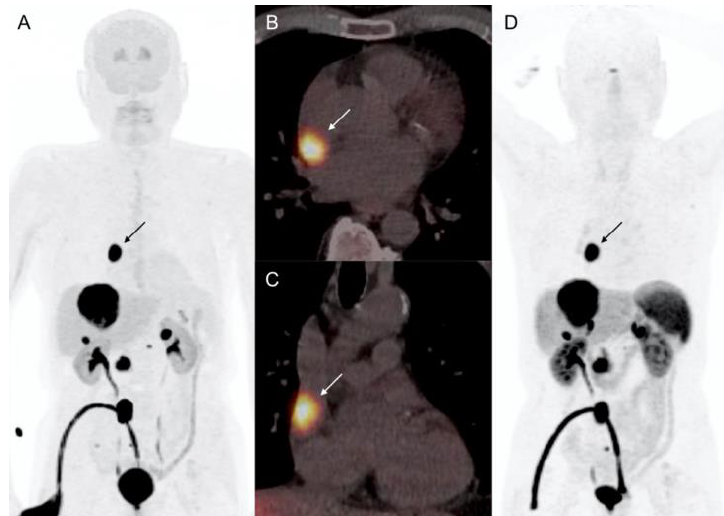
Figure 7. Patient 4. 76-year-old patient with metastatic si-NET. LV CM (arrows) showed intense uptake of both 18 F-DOPA and 68 Ga-DOTATOC. ( A ) 18 F-FDOPA PET MIP (anterior projection). ( B , C ) 18 F-FDOPA PET/CT short axis, and 4 chamber view. ( D ) 68 Ga-DOTATOC PET MIP (anterior projection).